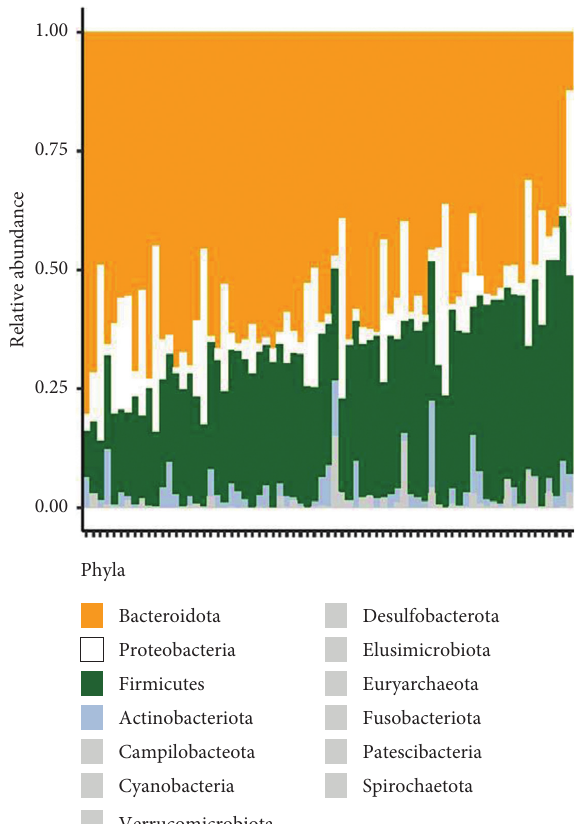
Figure 5: Gut microbiome composition among individuals. Rel- ative abundances of each phylum across every individual repre- sented by stacked bars. Four most significant phyla are shown in individual colors. All other phyla are grouped as “Other,” and their combined relative abundances are represented in grey. The relative abundance of Firmicutes ranged from ∼ 2% to 40%, while abun- dance of Bacteroidetes ranged from ∼ 75% to ∼